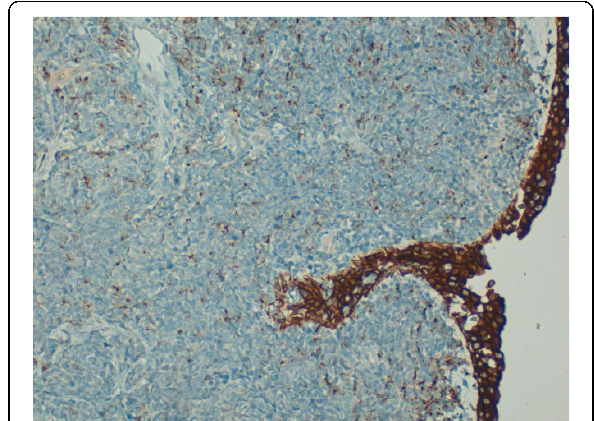
Figure 5 Tumor cells showed only focal positivity for AE1/AE3 in contrast with the diffuse positivity of the urothelium (20x).